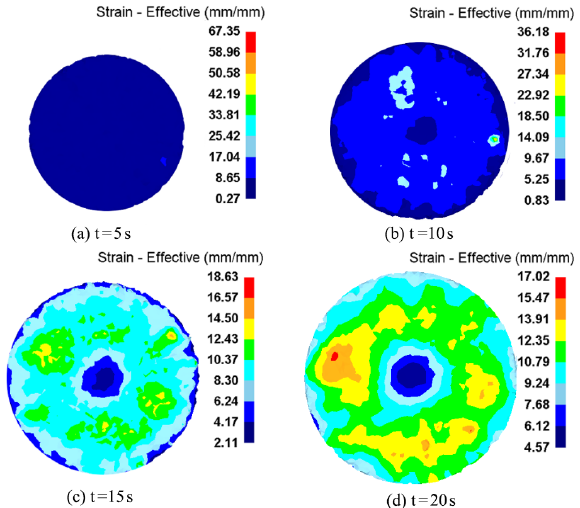
Figure 12. Surface PEEQ distribution of the disc.